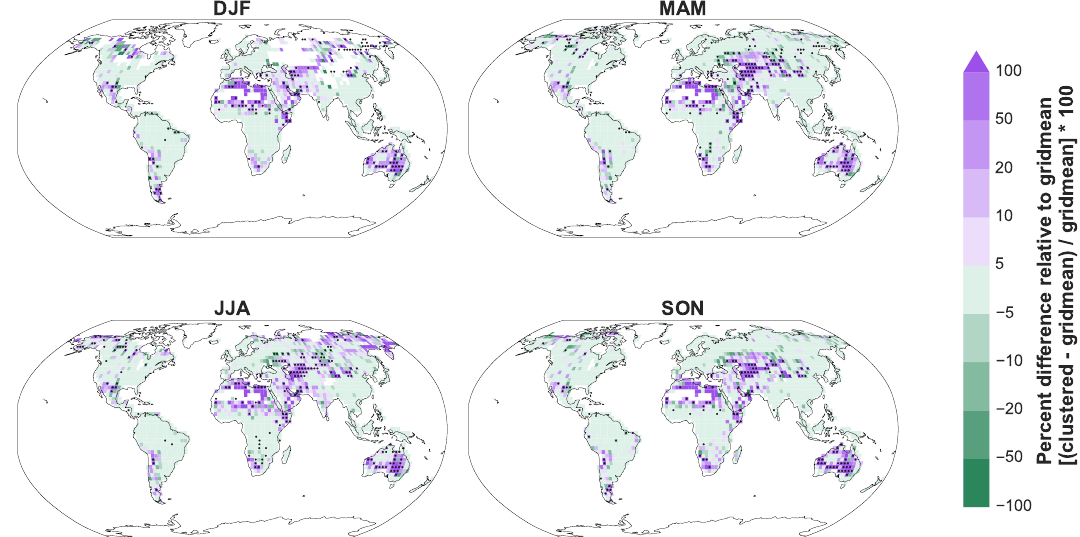
Figure A11. Percent difference in WUE between the Cluster and Gridmean simulations by season (mean of 1995–2015). Grid cells with monthly evapotranspiration of < 10 − 5 mm water were masked out to prevent instances of division by zero and overly large relative dif- ferences in regions of very small evapotranspiration. Positive values indicate the Cluster WUE is larger while negative values indicate the Gridmean WUE is larger. Dots indicate grid cells that are statistically significant (independent two-sample t -test p level < 0 .